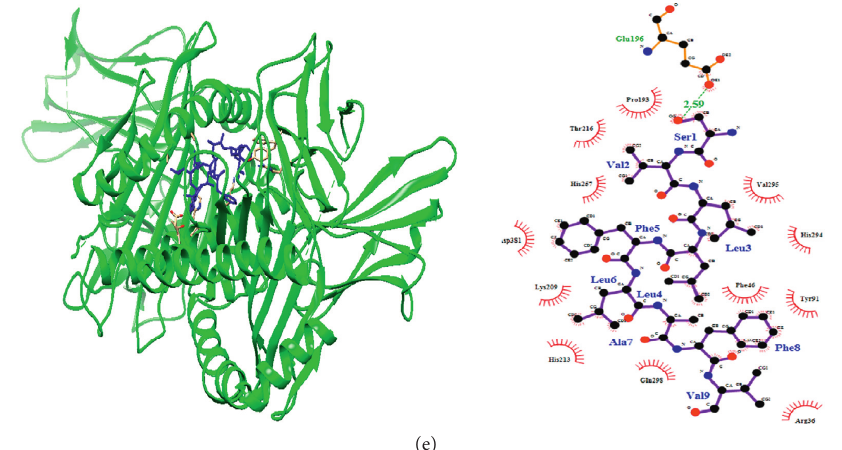
Figure 5: (Left) docking sites of predicted peptide against selected MHC-I (6APN and 1EFX) receptors. HLAs are shown in ribbon (green) form and epitope is shown in stick (blue). (Right) interacting residues between ligand and receptor. H-bond interaction is shown in